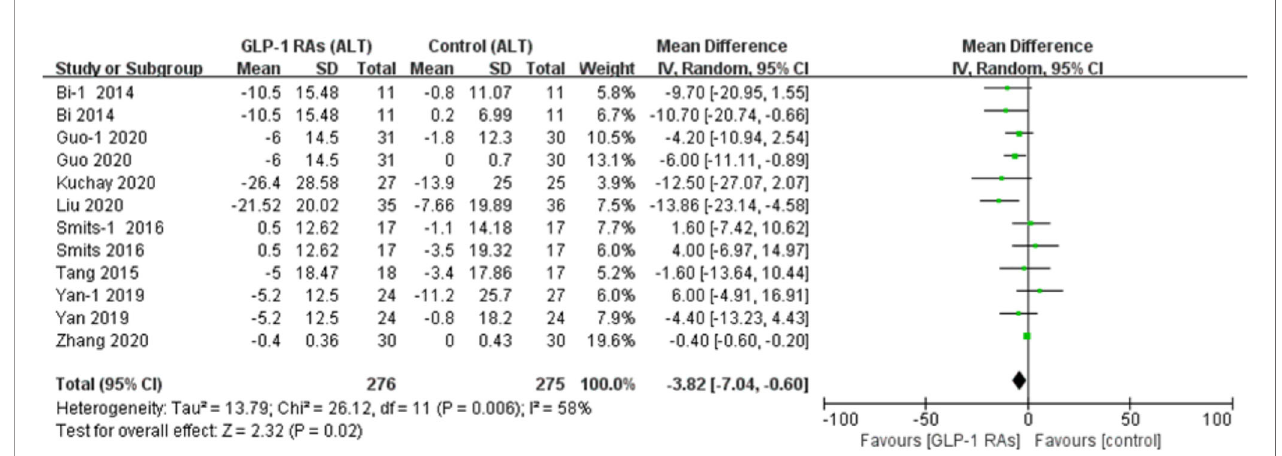
FIGURE 9 | Glucagon-like peptide-1 receptor agonists (GLP-lRAs); alanine aminotransferase (ALT); SD, standard deviation; CI, con fi dence interval; IV, inverse variance; Bi-l, concluded exenatide vs pioglitazone; Guo-l, concluded liraglutide vs insulin; Smits-l, concluded liraglutide vs placebo; Yan-1, concluded liraglutide vs sitagliptin.